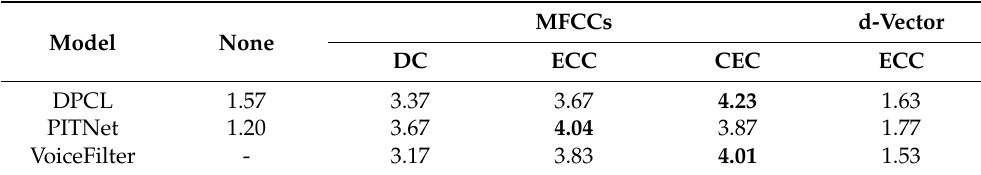
Table 2. Average MOS values corresponding to the three speech separation models with and without voiceprint feature integration.